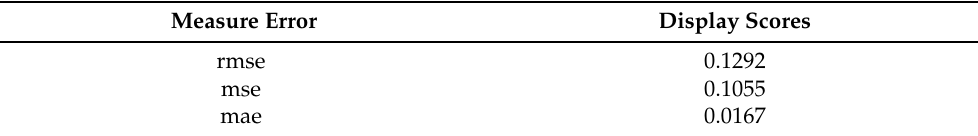
Table 5. Evaluating the performance of an LSTM model in our case